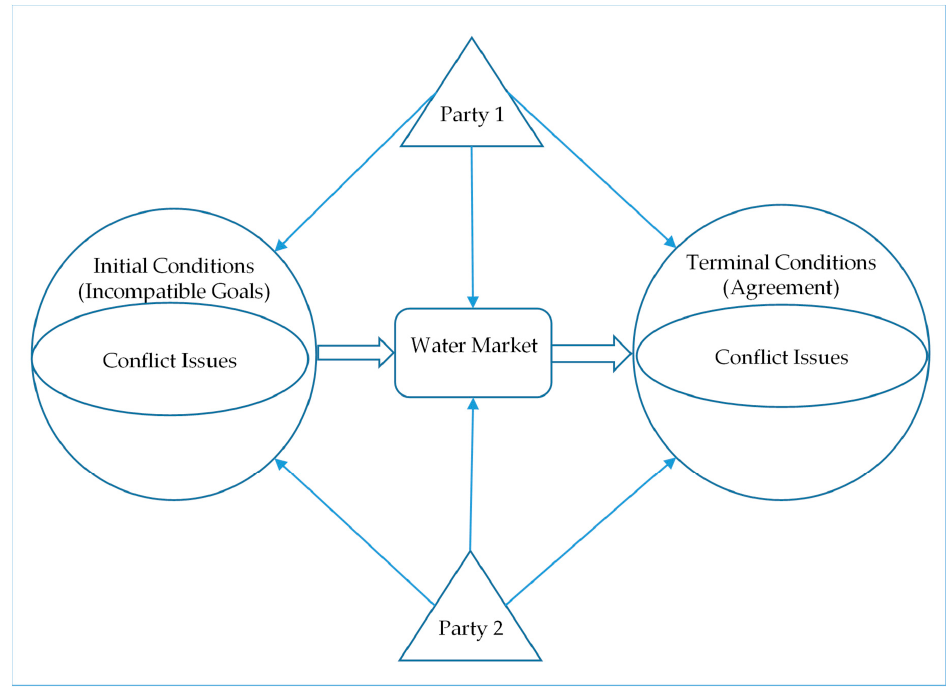
Figure 6. Structure of Game-Theoretic Mechanism. Table 5. Game-Theoretic Mechanism—Theory and Implementation.